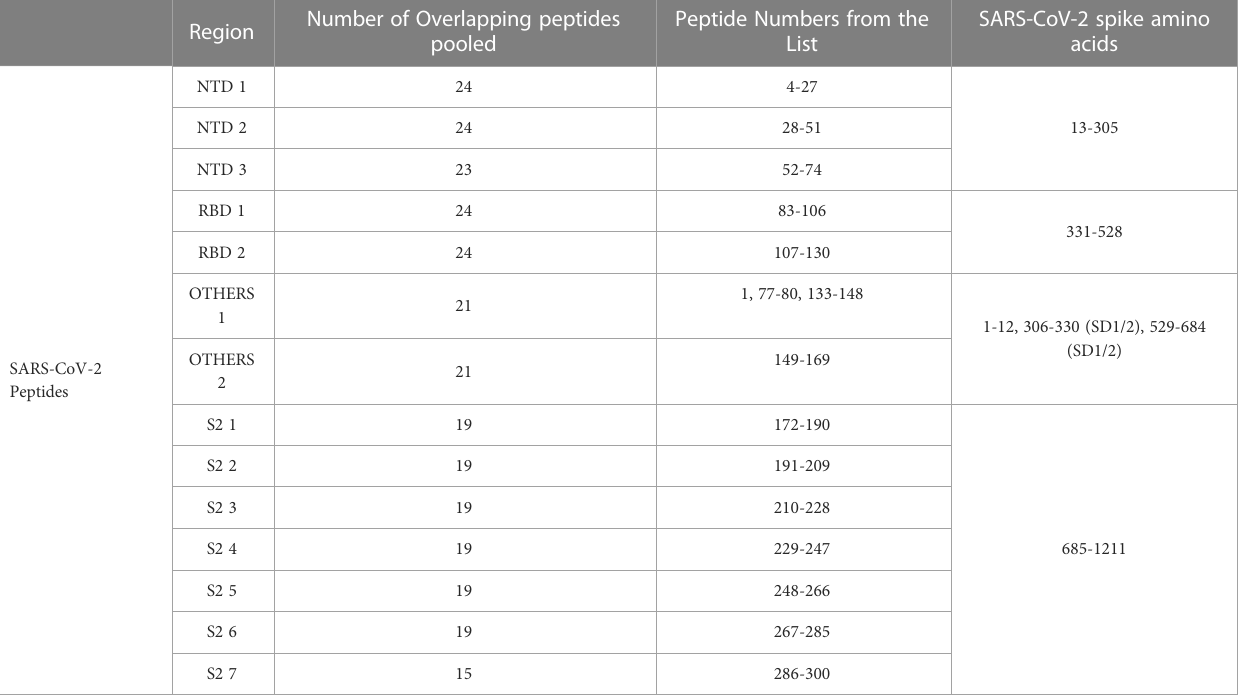
Peptide Numbers from the SARS-CoV-2 spike amino List